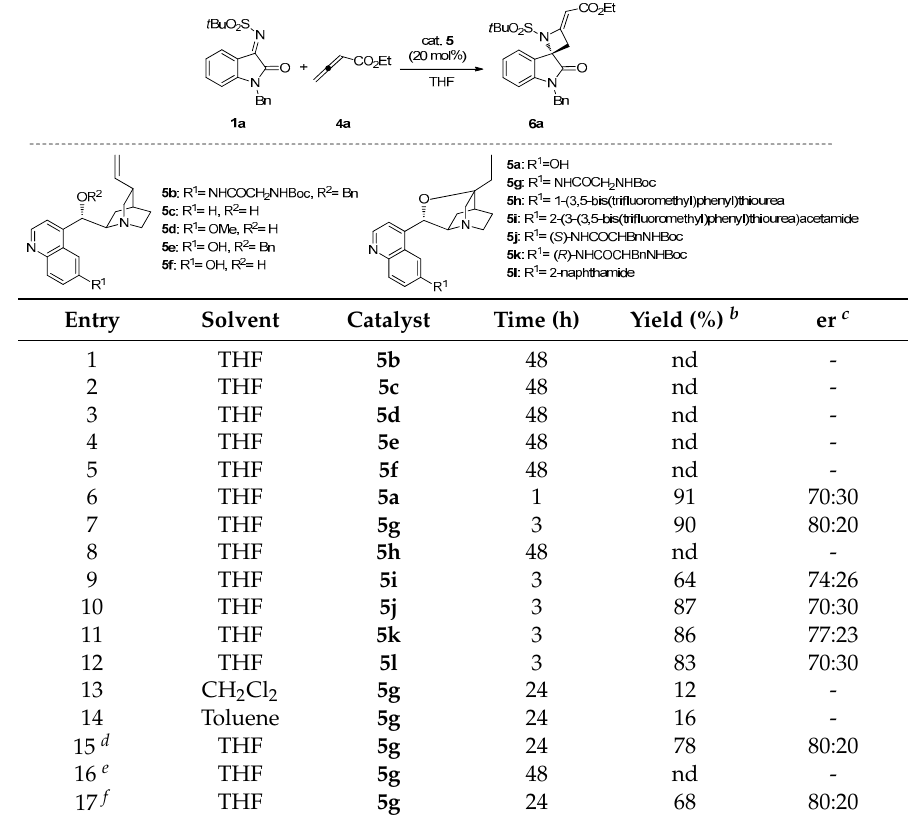
Table 2. Catalyst and solvent screen for the reaction of N - tert -butylsulfonyl imine 1a with ethyl buta-2,3-dienoate ( 4a ). a